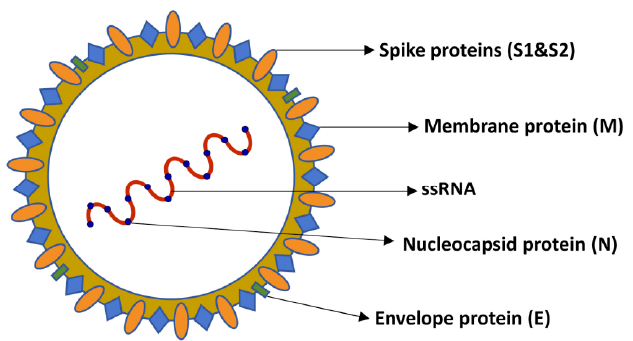
Figure 1. Schematic representation of SARS-CoV-2: the structure of SARS-CoV-2 is formed by the structural proteins, including the spike (S), membrane (M), envelope (E), and nucleocapsid (N) proteins that are involved in morphogenesis, viral assembly, host infection, and membrane fusion.